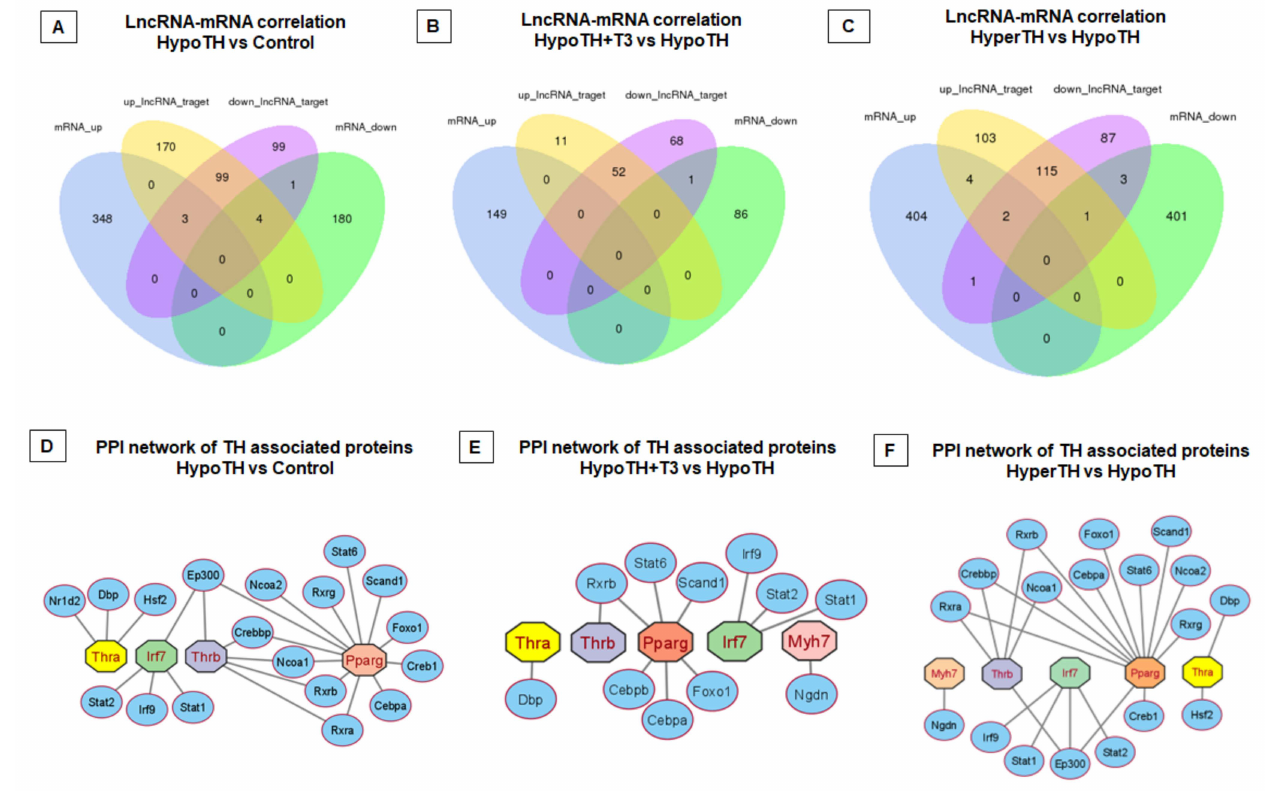
Figure 8. LncRNA-mRNA correlation Analysis and PPI network. (A–C) LncRNA-mRNA correla- tion analysis. Groupwise comparisons identified the LncRNA-mRNA partners in ( A ) HypoTH vs. Control, ( B ) HypoTH + T3 vs. HypoTH, and ( C ) HyperTH vs. HypoTH groups. Only statistically significant ( p -adj < 0.05) and differentially expressed lncRNA and mRNA targets were included in this correlation analysis. ( D – F ) Protein–protein interaction (PPI) network for genes co-expressed with significantly altered lncRNAs and critically involved in cardiac or TH pathways in ( D ) HypoTH vs. Control, ( E ) HypoTH + T3 vs. HypoTH, and ( F ) HyperTH vs. HypoTH groups. The interactions that showed p < 0.05 were included in this